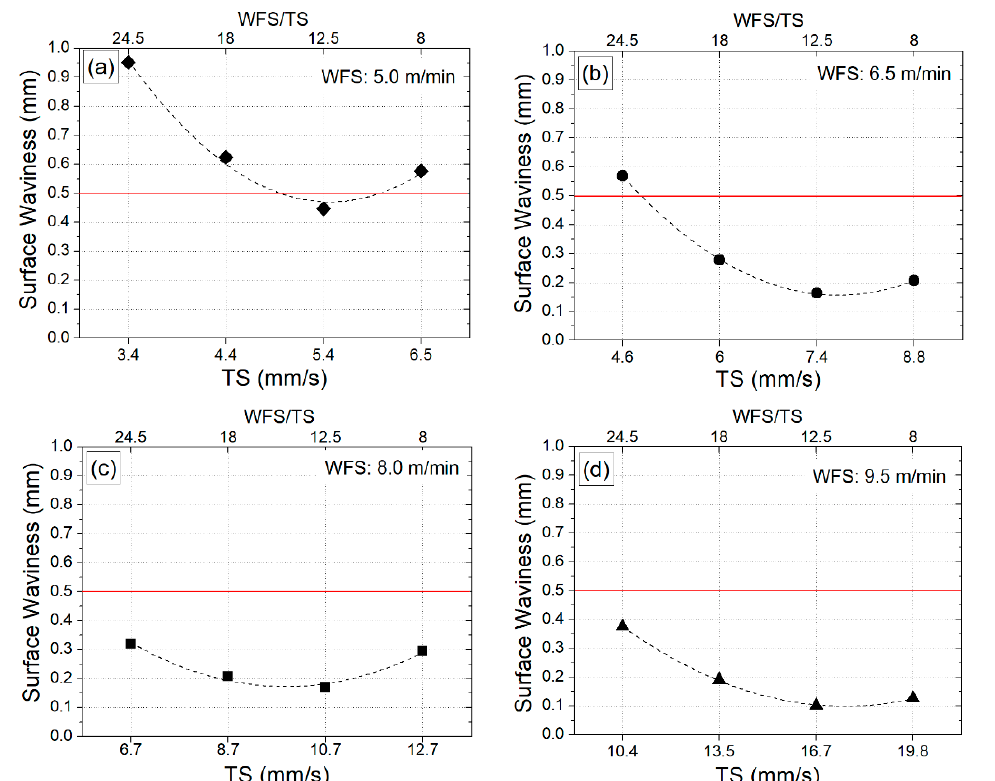
Figure 10. Surface waviness according to WFS and TS values (acceptance criteria: Below the red line): ( a ) WFS: 5.0 m/min, ( b ) WFS: 6.5 m/min, ( c ) WFS: 8.0 m/min and ( d ) WFS: 9.5 m/min.